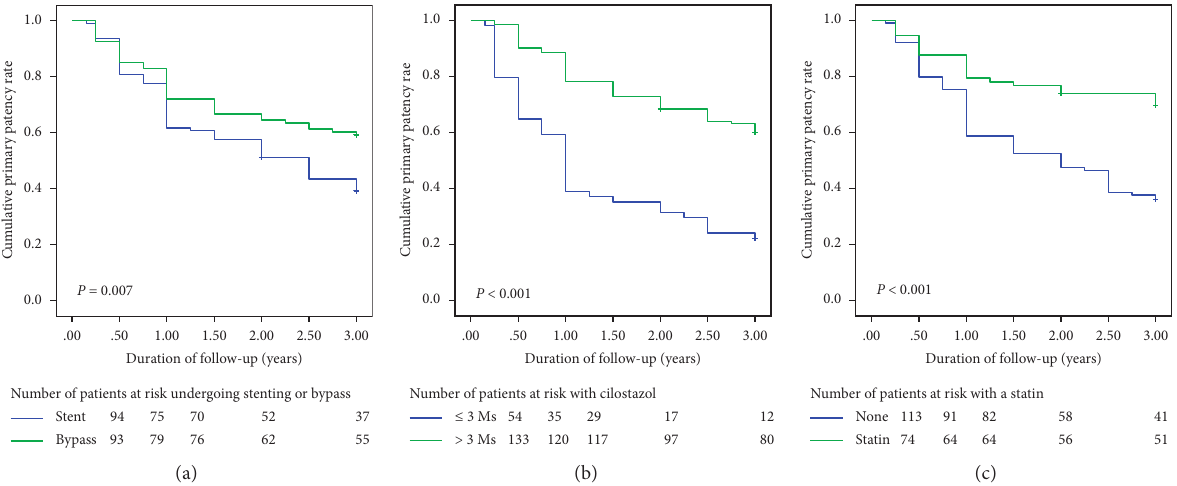
Figure 1: (a) Patients who underwent bypass surgery had a better patency rate than patients who received stenting treatment (log rank test, P � 0 . 007). (b) Patients who received cilostazol treatment for more than 3 months had a patency rate than patients who received treatment for fewer than 3 months (log rank test, P < 0 . 001). (c) Patients receiving statin treatment had a patency rate than those who did not receive treatment (log rank test, P < 0 .